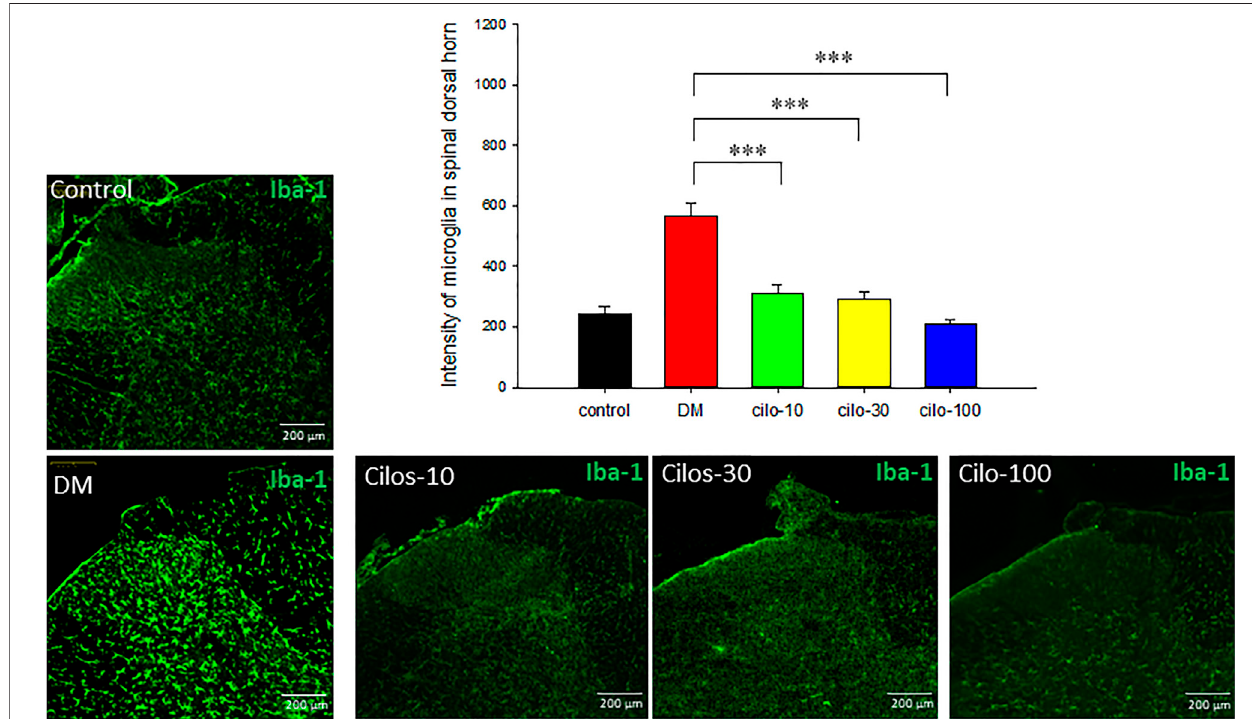
FIGURE 4 | Oral cilostazol signi fi cantly reduced the levels of activated microglia expression in the spinal dorsal horn (SDH) of diabetic (DM) rats. Immuno fl uorescence assays revealed increased expression of activated microglia (Iba-1; green) in the SDH of 2-month streptozotocin-induced DM rats, and reduced expressions in the cilostazol-treated DM rats. Samples from DM rats treated with all three oral cilostazol dosages demonstrated signi fi cantly reduced levels of activated microglia (intensity of green fl uorescence) in the SDH. Results are expressed as mean SEM for a minimum of fi ve rats for each group. Statistical signi fi cances between the DM control and cilostazol DM treatment groups were calculated with the Mann – Whitney U test, ***; p < 0.001.